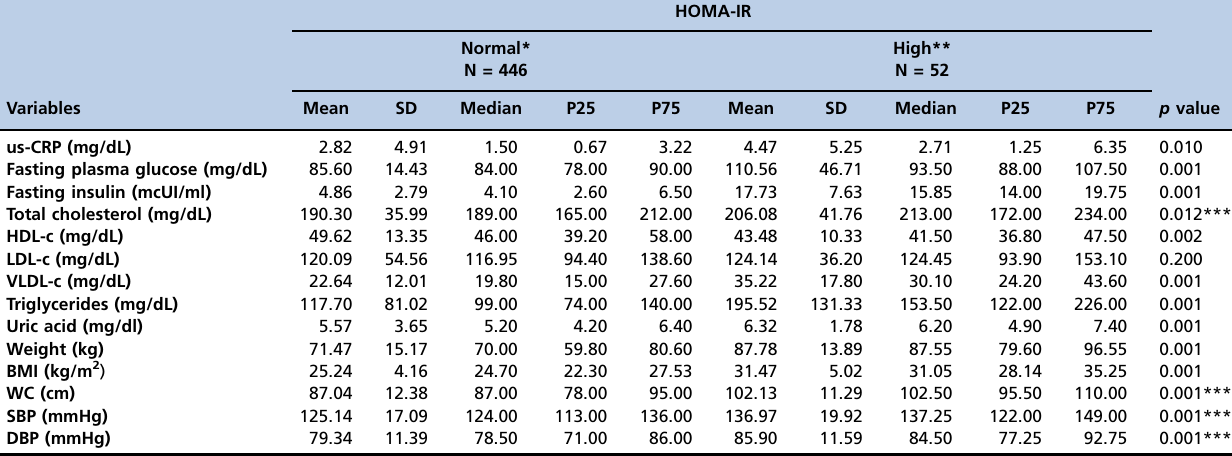
Values are given as the mean and SD (standard deviation), median, and 25 th and 75 th percentiles. *N = 446